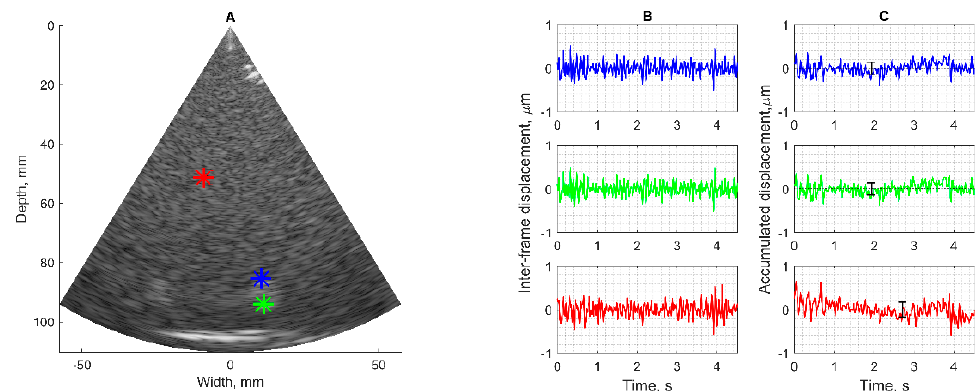
Figure 2. Results of the detection algorithm evaluation of targeted radiofrequency (RF) signals from the static phantom (Model 532A): ( A ) B-scan of the phantom structure with targets of interest; ( B ) the detected positions of static targets presented in the form of inter-frame displacements; ( C ) the calculated variability of static target positions or displacements relative to the transducer. Mean and standard deviation calculated from n = 21, error bar illustrates standard deviation up to 0.2 µm.